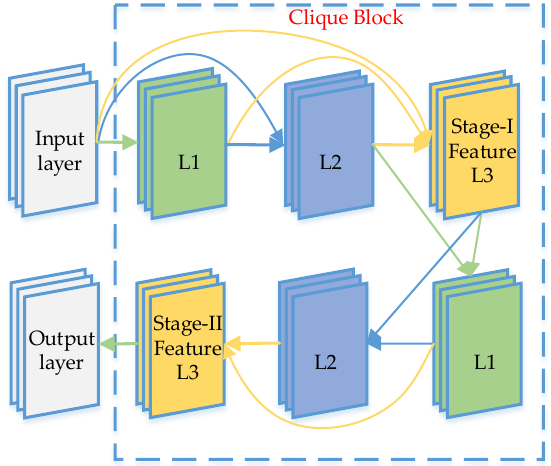
Figure 4. Clique block: The data entered from the previous block to the next layer will be looped through the block